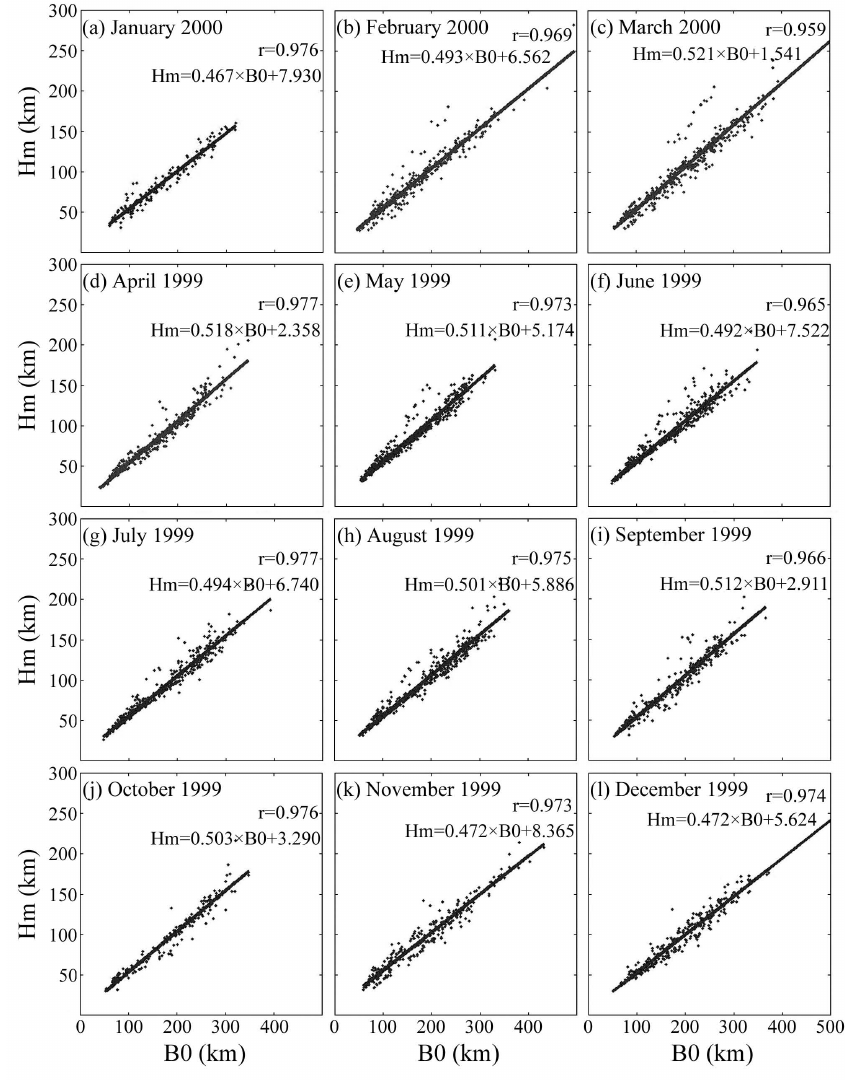
Fig. 9. The scatter plots of Hm versus B0 during April 1999–March 2000. The correlation coefficient ( r ) of Hm and B0 and the equation of least-squares straight line (solid line) for each month are placed in the upper-right